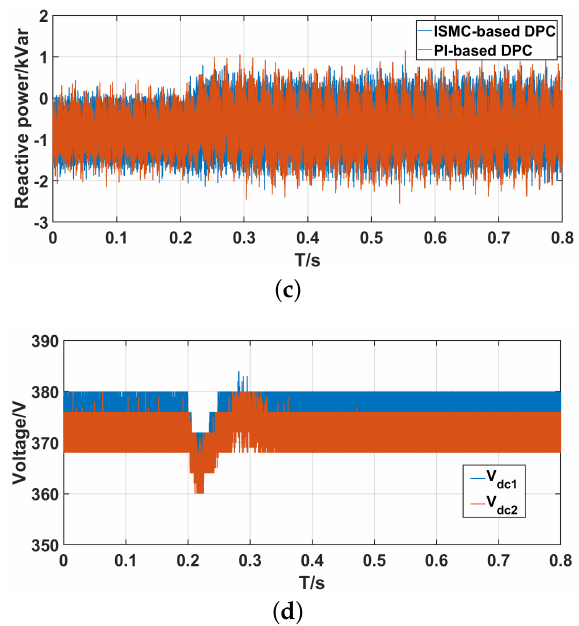
Figure 8. Dynamic reponse of DC-link voltage, active power, reactive power and voltages of two DC-link capacitors. ( a ) DC-link voltage; ( b ) Active power; ( c ) Reactive power; ( d ) Voltages of two